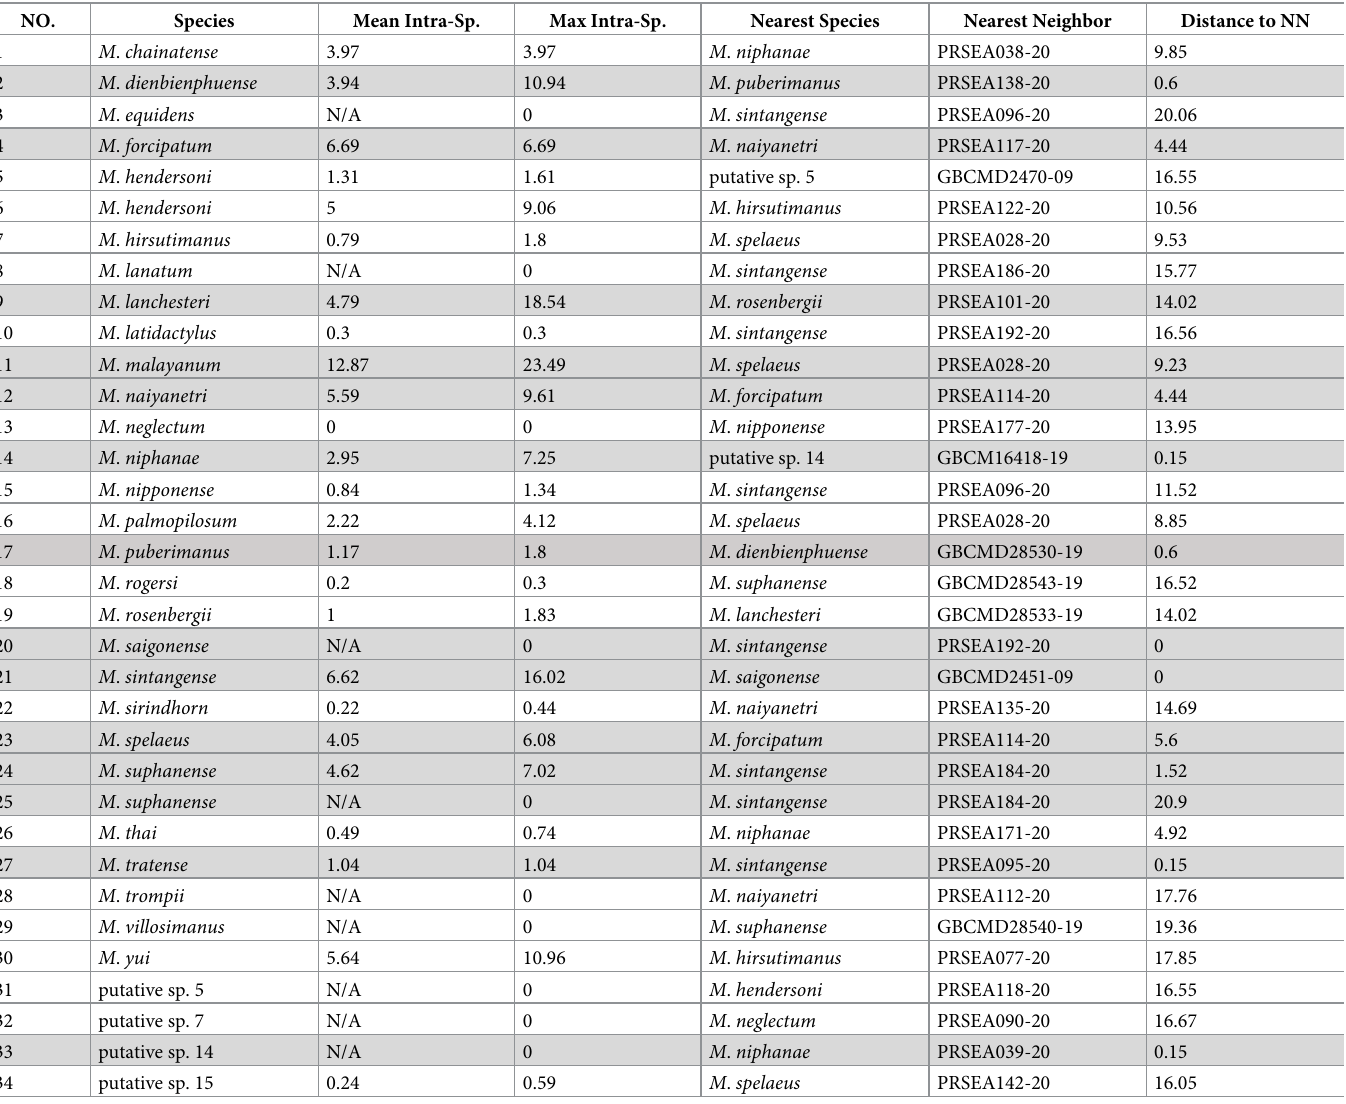
Table 3. Summary of Mean-Max intraspecific variation in each Macrobrachium species and the distance to nearest-neighbor species. NO. Species Mean